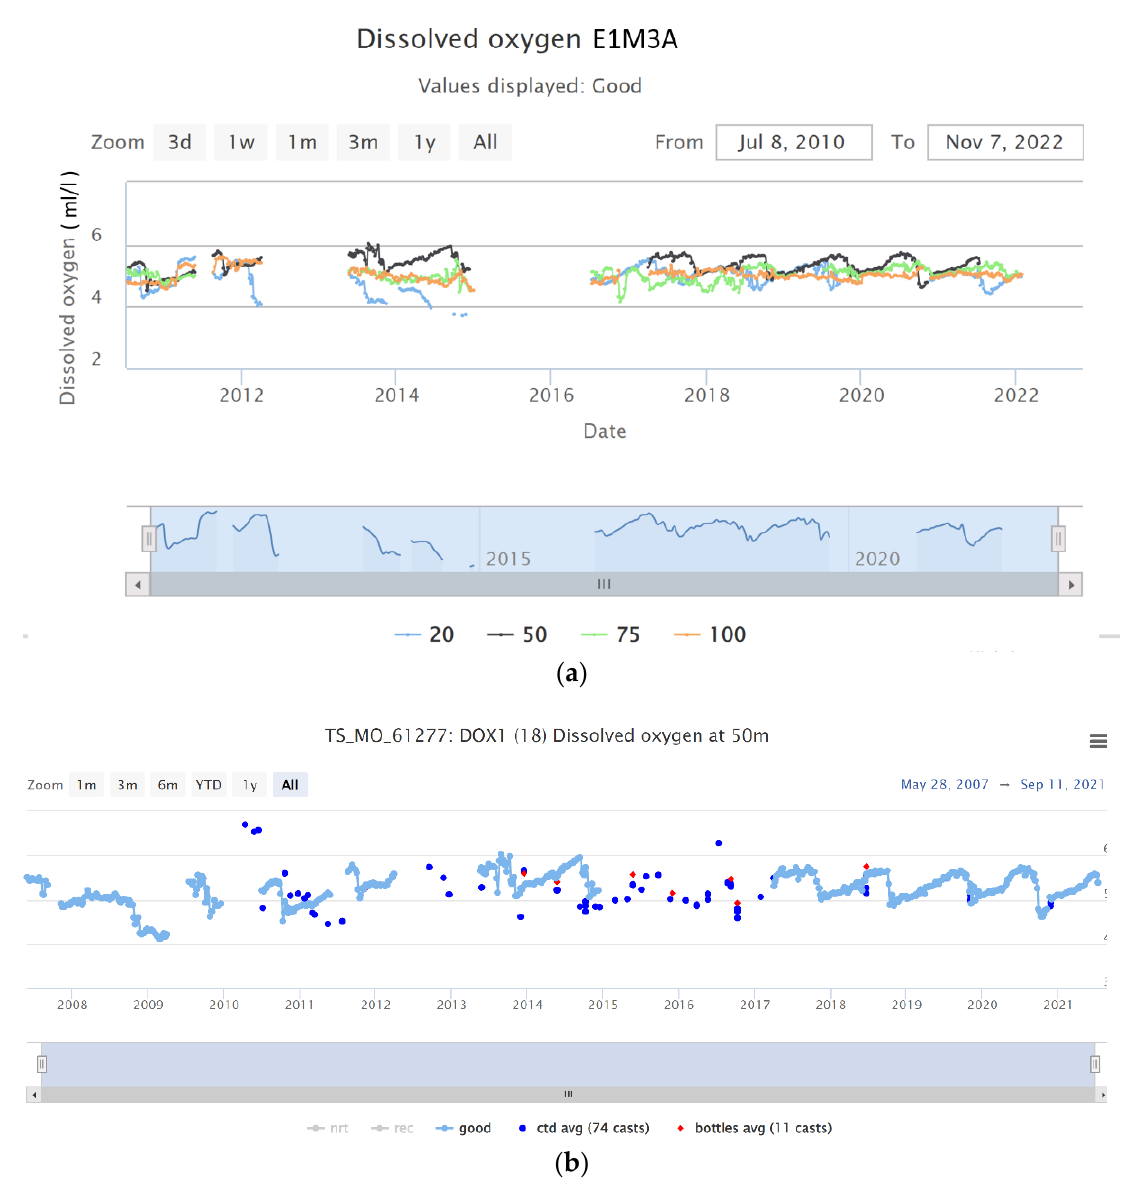
Figure 7. This figure demonstrates the radical improvement of the dissolved oxygen data in the POSEIDON buoys by the introduction of a new optical sensor in 2017. Panel ( a ) presents the dissolved oxygen timeseries form the E1M3A where the new sensors data corresponds to the period after 2017. Panel ( b ) focuses on the 50 m time series to demonstrate the better correlation of the optical sensor data with filed validation data (blue and red dots).